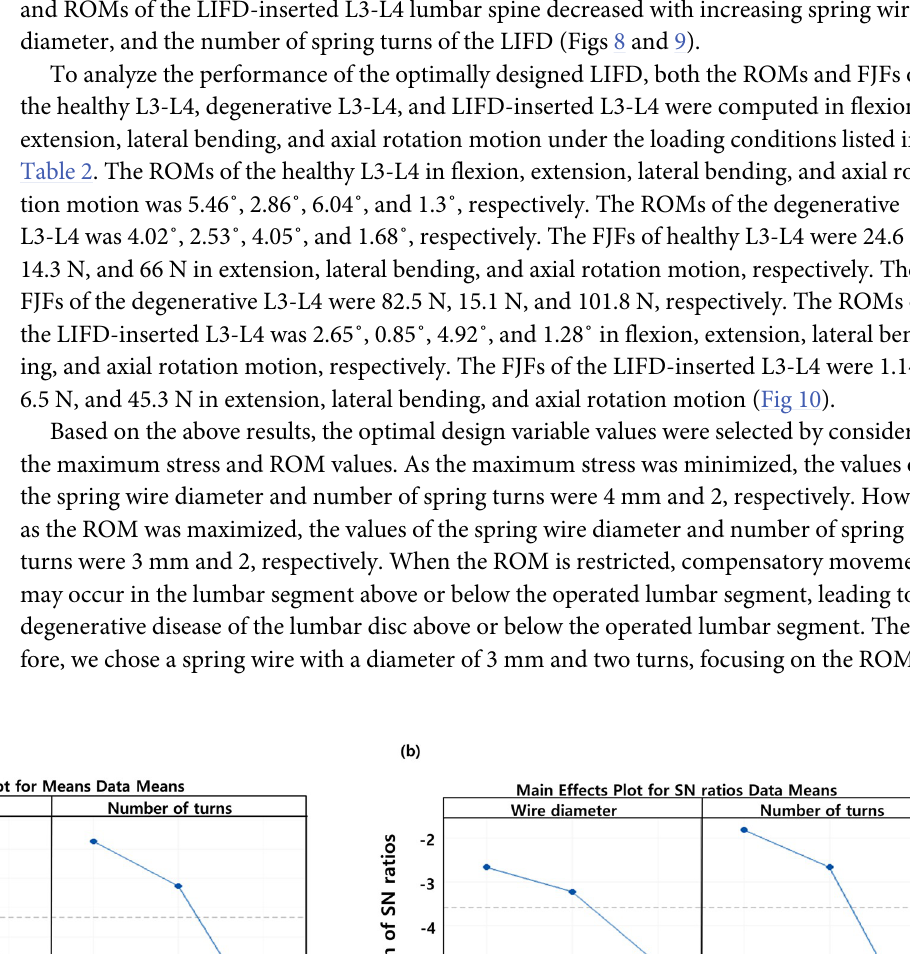
PLOS ONE | https://doi.org/10.1371/journal.pone.0265926 April 7,